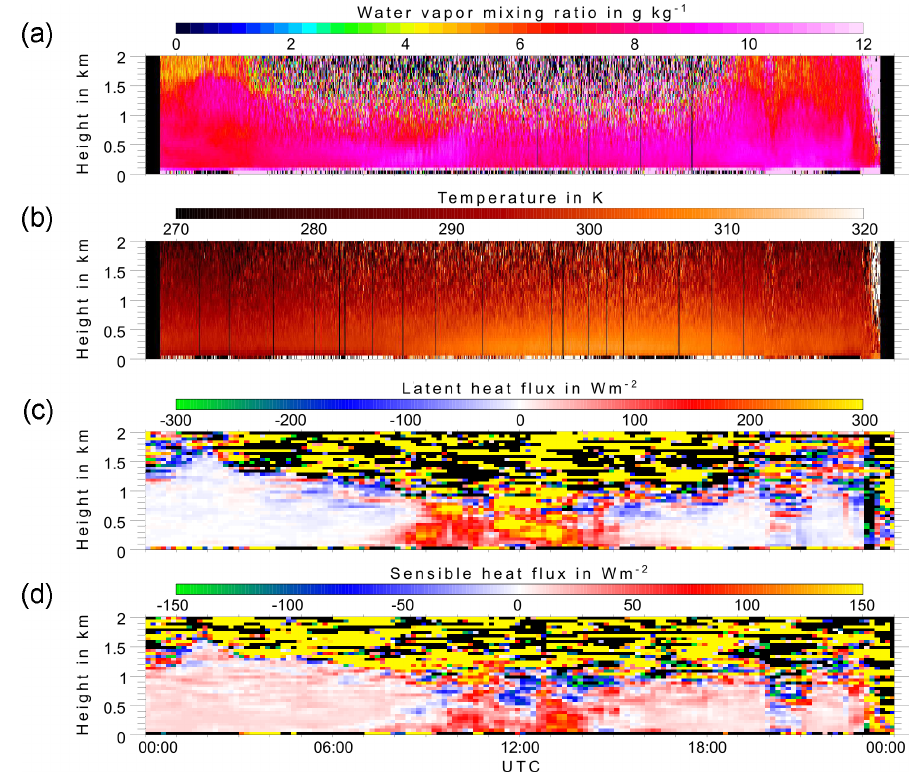
Figure 5. Water vapor mixing ratio and temperature time series for 27 June 2021 are plotted in (a) and (b) . In (c) and (d) the latent and sensible heat fluxes are shown for that day.